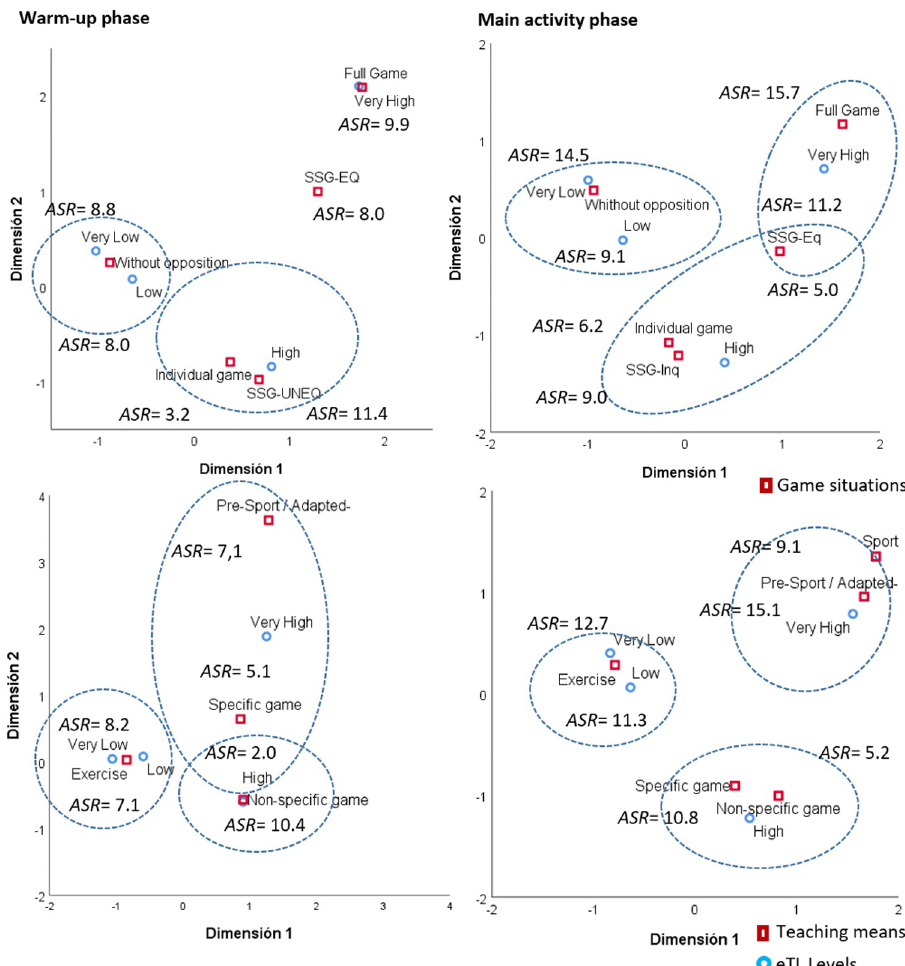
Fig 1. Associations between means and learning situations and the levels of